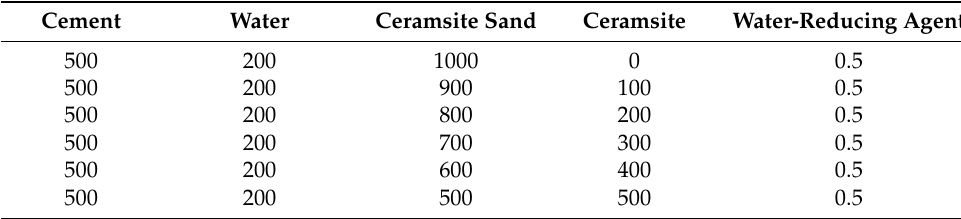
Table 1. Mix proportions of ceramsite per one cubic meter